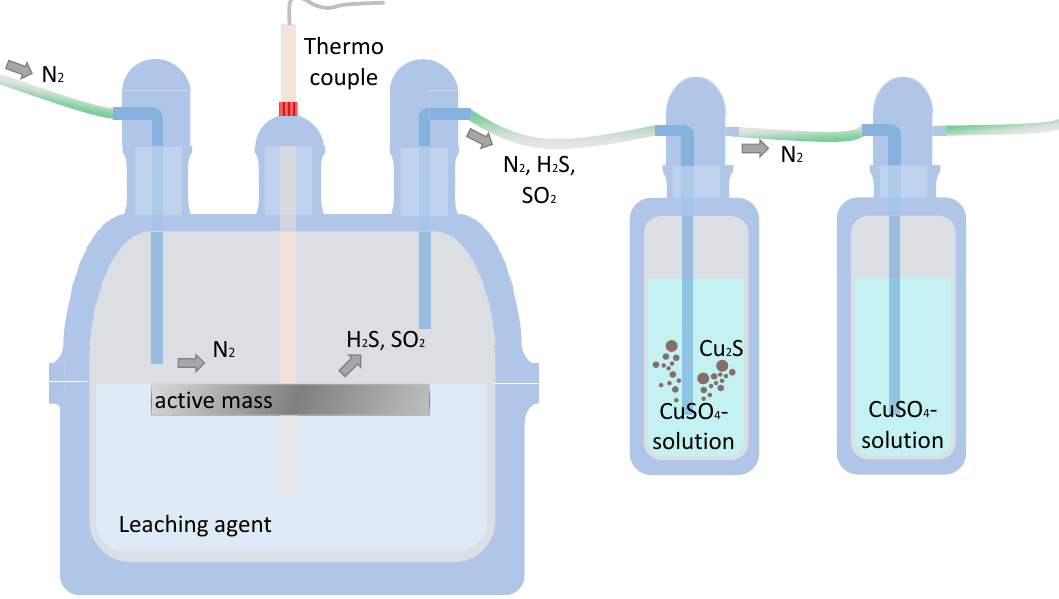
Figure 5. Schematic illustration of the applied leaching step set-up: Li–S black mass is inserted into a sealed three-neck flask and the add-on reactors for S recovery are represented by gas washing bottles (both borosilicate glass).